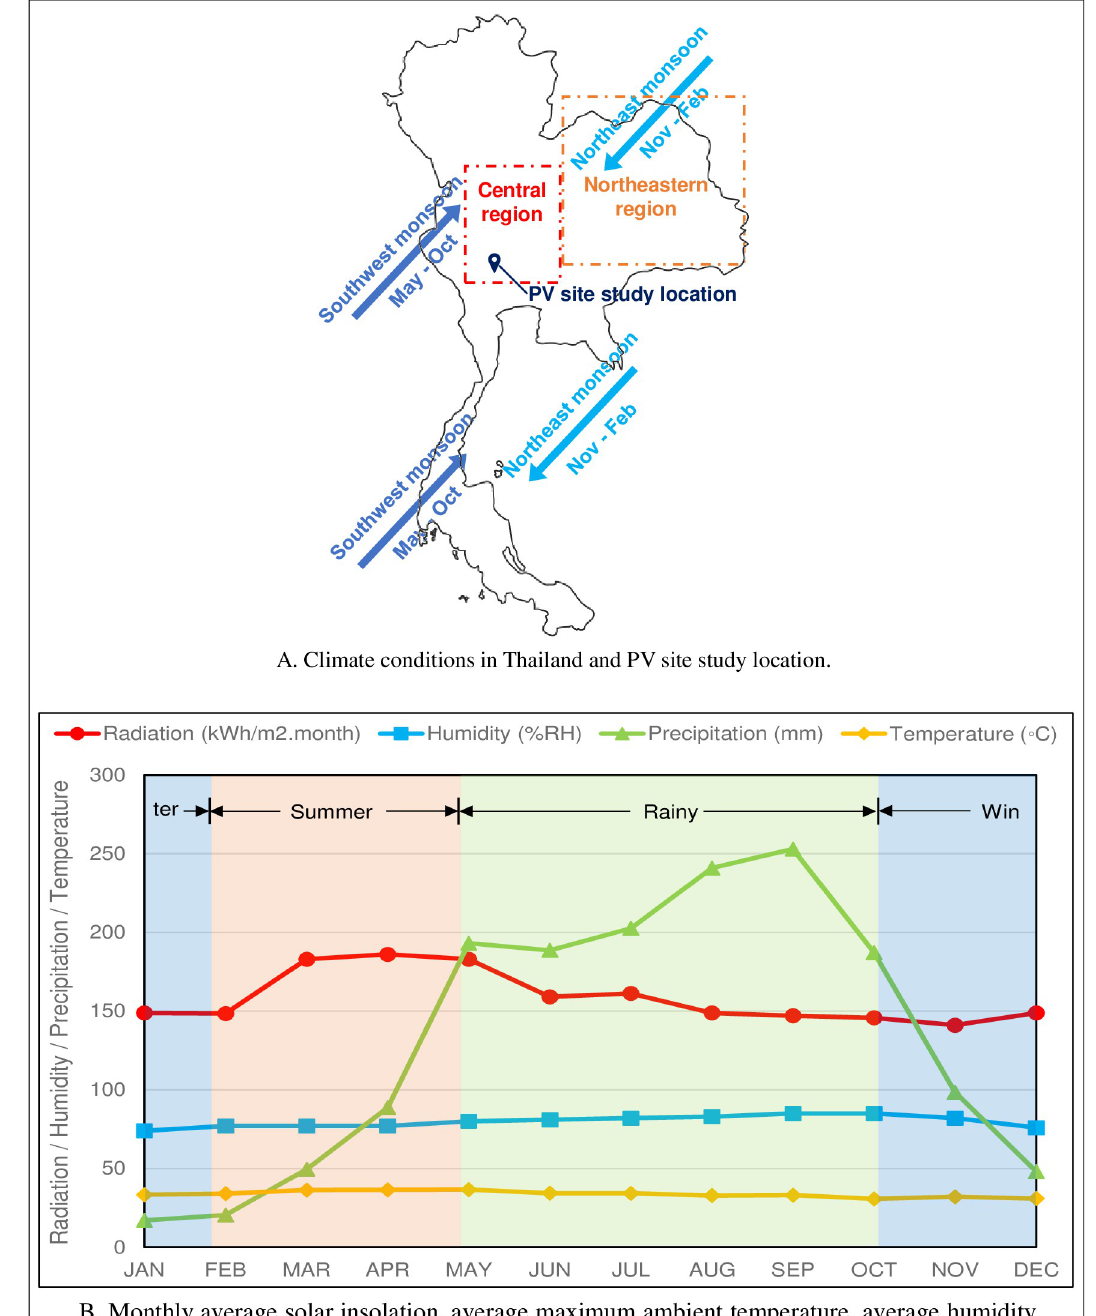
Fig 2. Overall climate conditions of the country and regions of highest solar radiation. A. Climate conditions in Thailand and PV site study location. B. Monthly average solar insolation, average maximum ambient temperature, average humidity, and average rainfall in Thailand. The precipitation is average monthly rainfall during 30-year period [3–6].